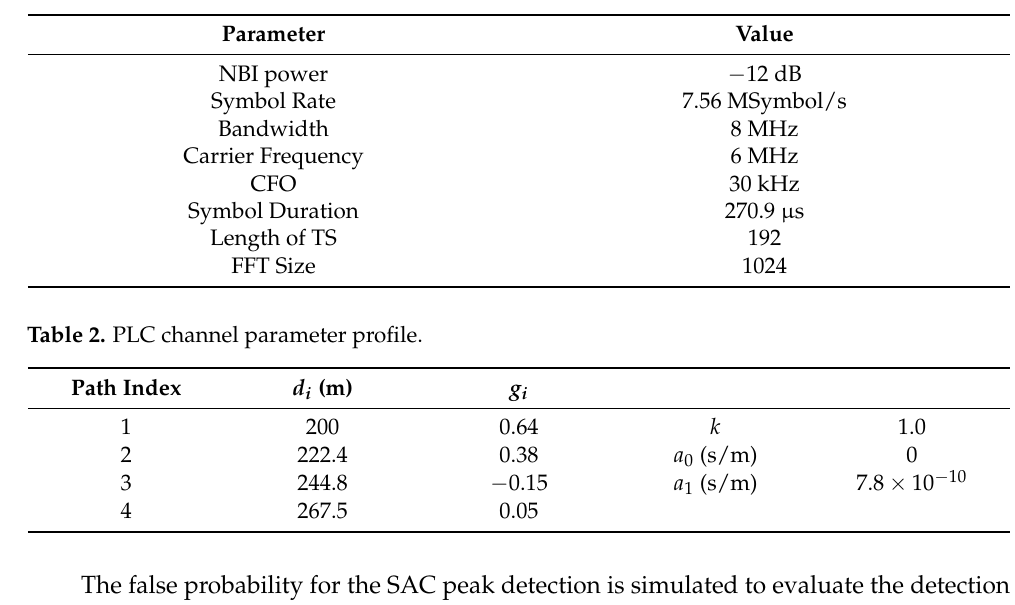
Table 1. Simulation parameter.